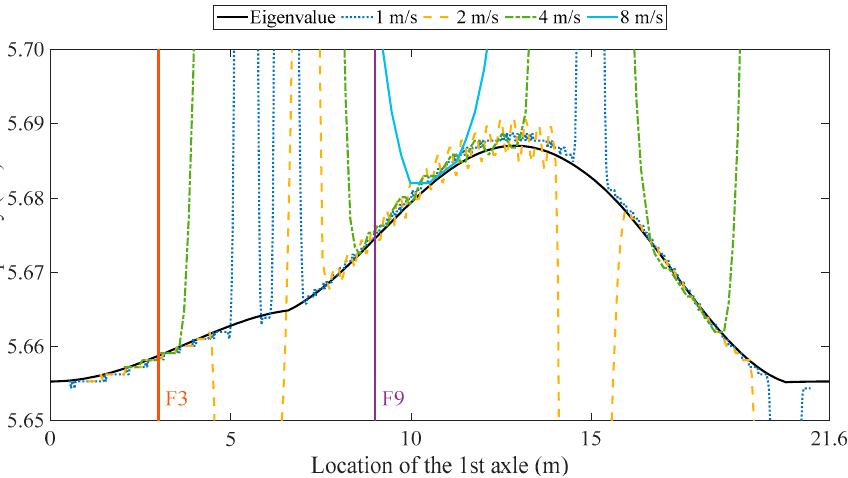
Figure 9. Comparison of the eigenvalue curve and the STFT of the undamped bridge response due to the truck travelling on a smooth profile at four different speeds.